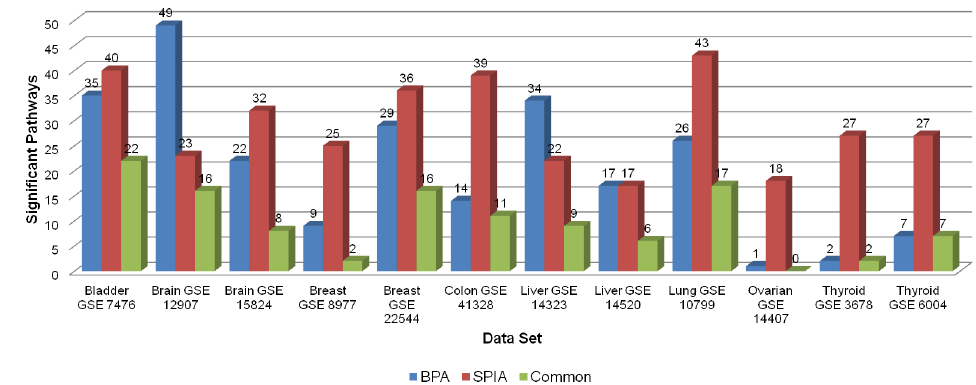
Figure 2. Number of pathways found significant in real microarray data sets using BPA and SPIA methods.